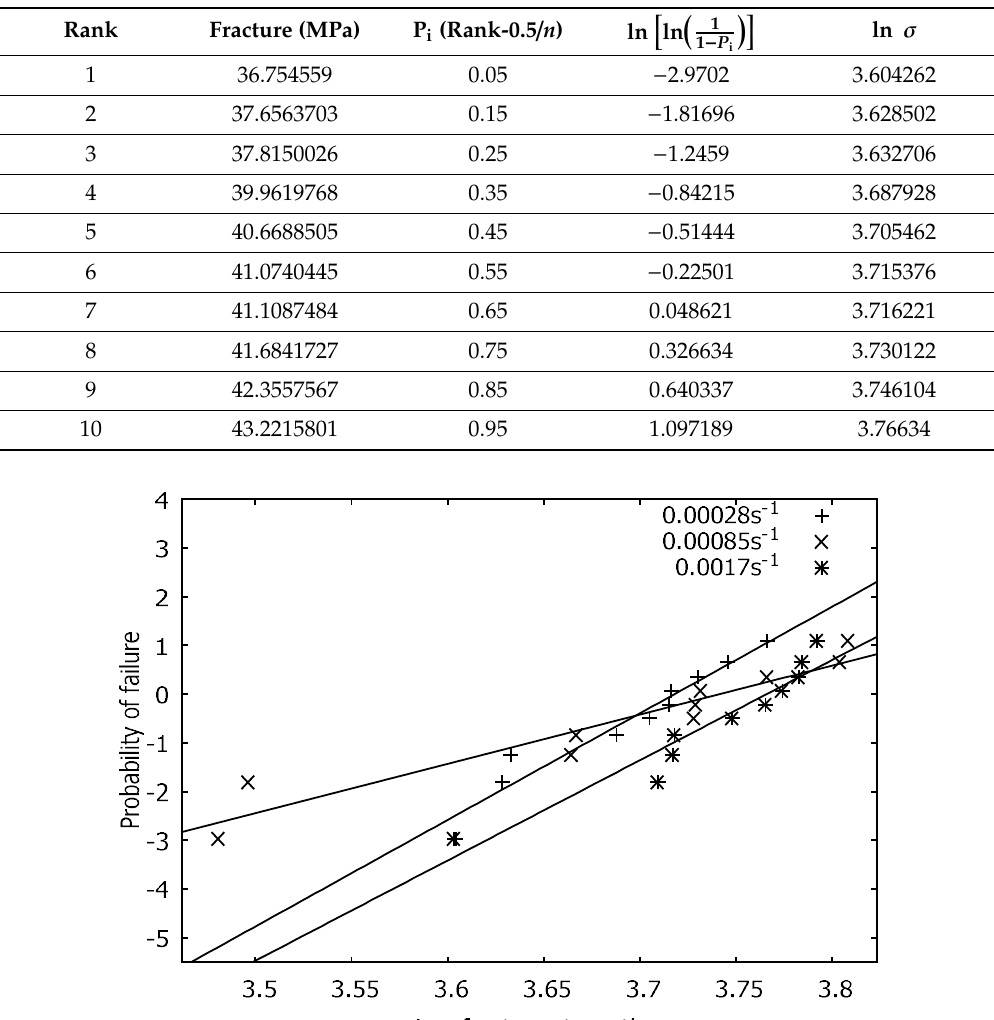
Table 1. Sample mechanical data for 300 µ m baggage particle-reinforced composites under a quasi-static strain rate.